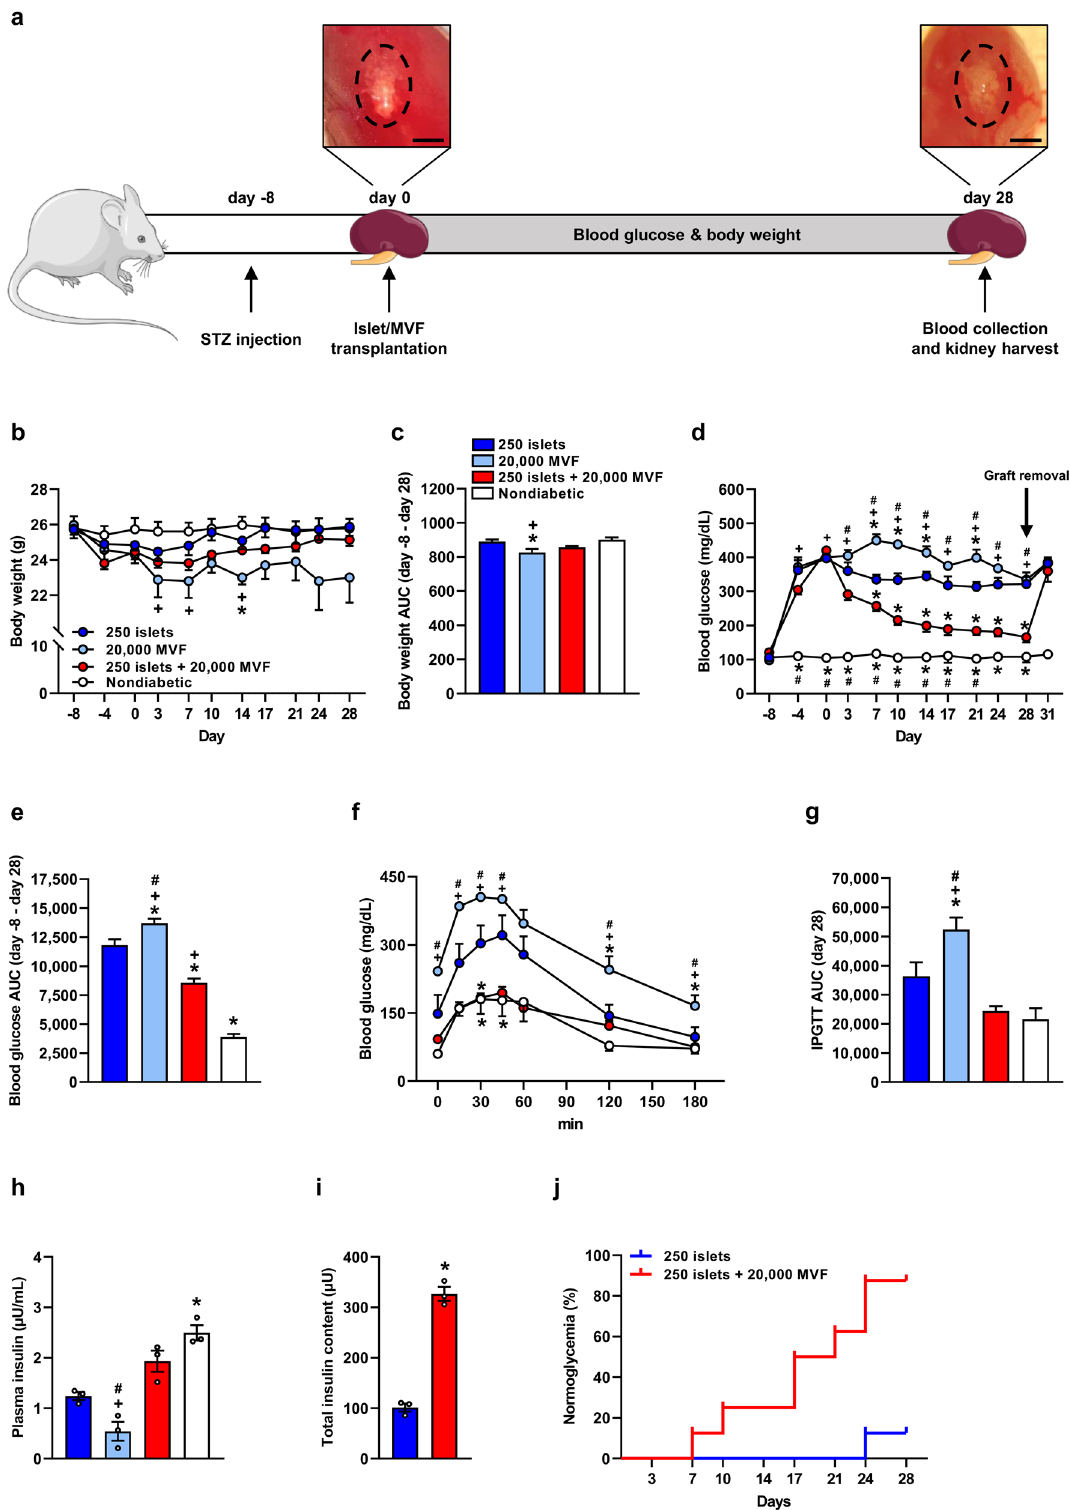
plasma insulin level and the total insulin content of the grafts were signi fi cantly higher (Fig. 2h, i). Of interest, the co-transplantation of 250 islets and 20,000 MVF reversed diabetes in 87.5% of recipients, whereas only 12.5% of mice receiving 250 islets alone were normoglycemic on day 28 (Fig.